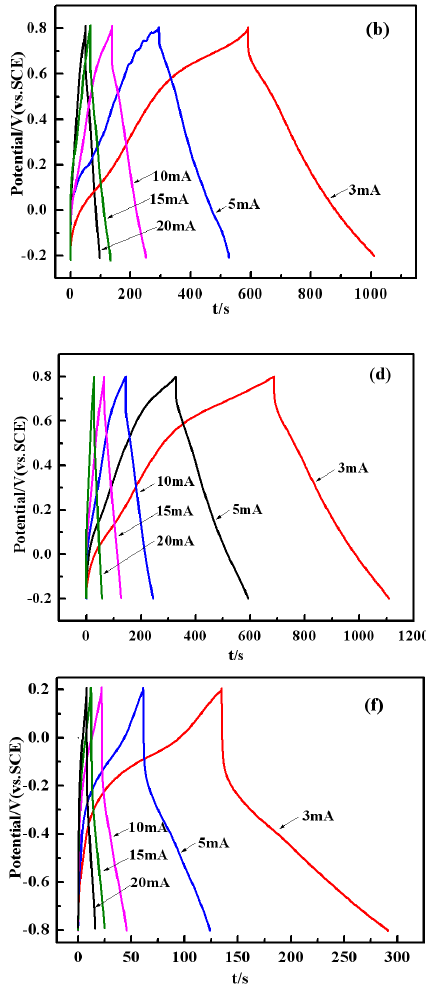
Figure 8. Galvanostatic charge-discharge curves of 8 wt% SWNTs composite: ( a ) in 1M H SO and ( b ) in 1 M KCl. Galvanostatic charge-discharge curves of 16 wt% MWNTs 2 4 composite: (c ) in 1 M H SO and (d) in 1 M KCl. Galvanostatic charge-discharge curves of 2 4 8 wt% SWNTs composite in 6 M KOH ( e ); Galvanostatic charge-discharge curves of 16 wt% MWNTs composite in 6 M KOH ( f